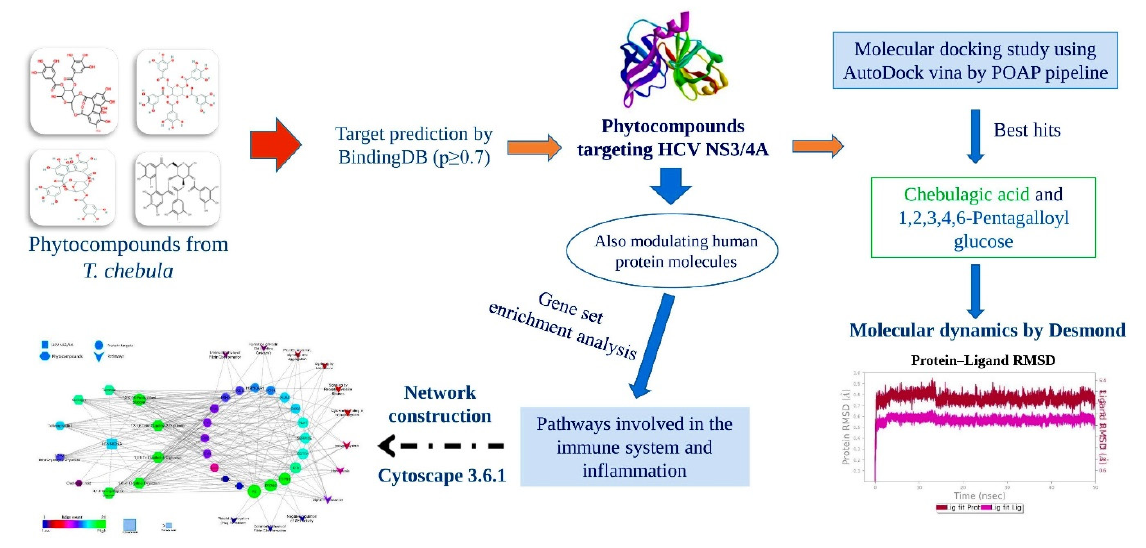
Figure 2. Workflow followed in the current study.